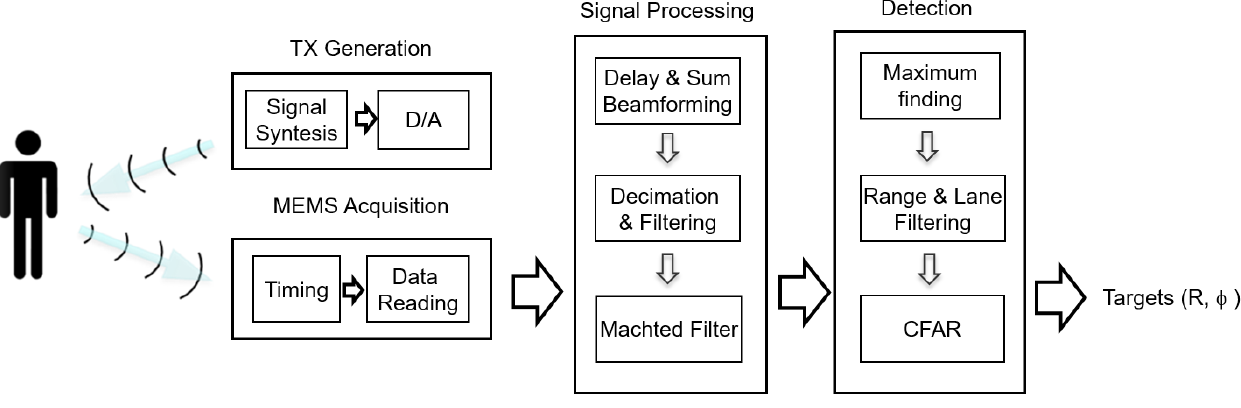
Figure 3. Processing algorithms.